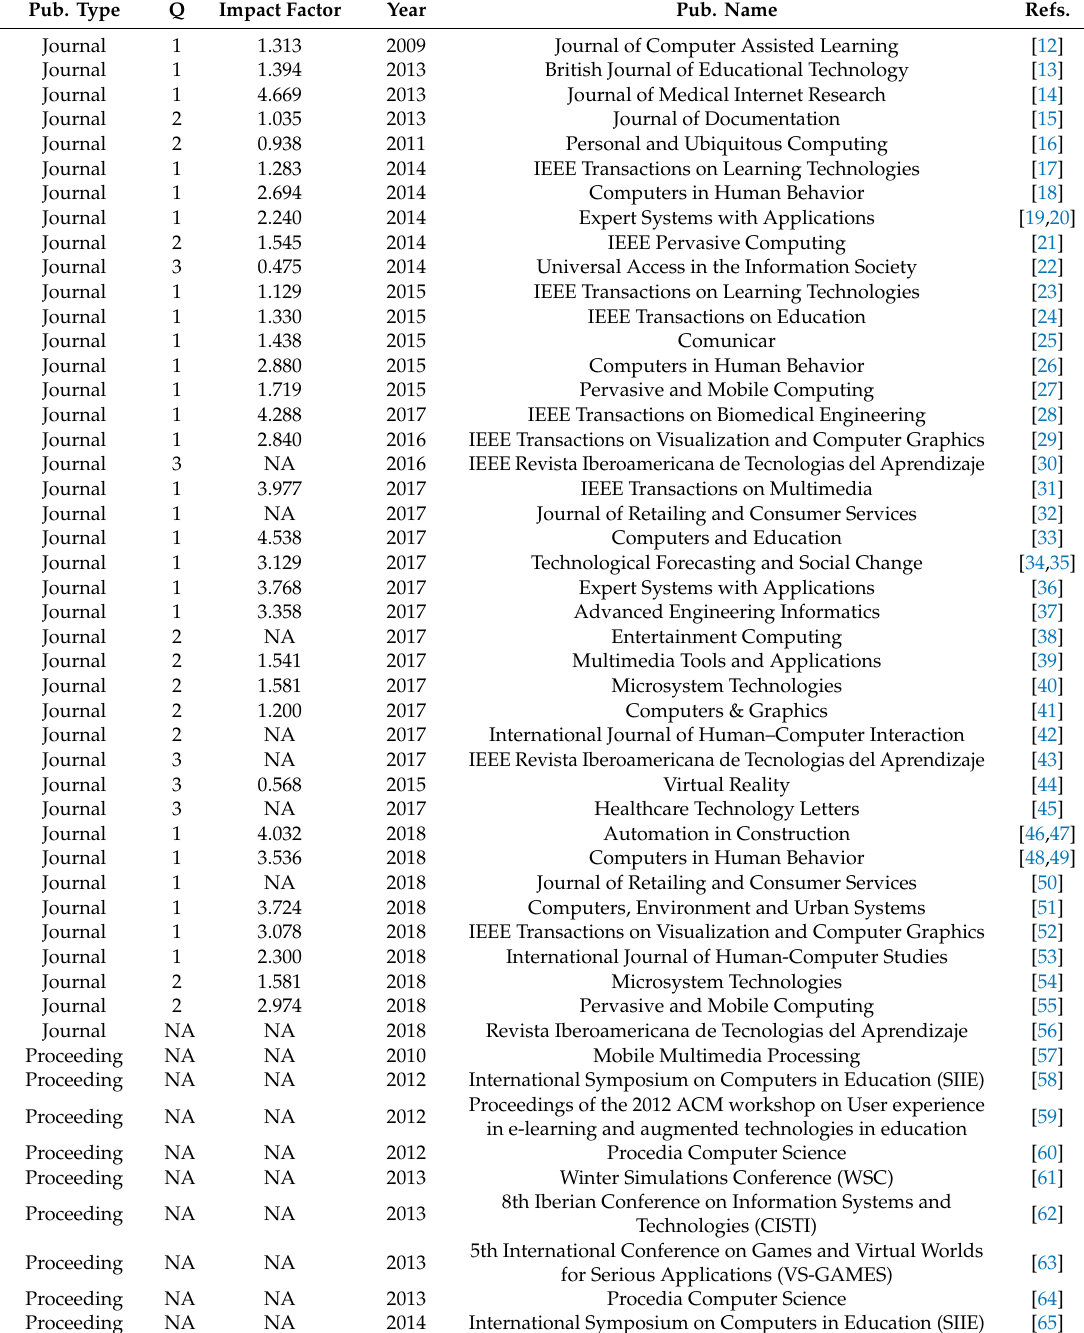
Table 5. List of